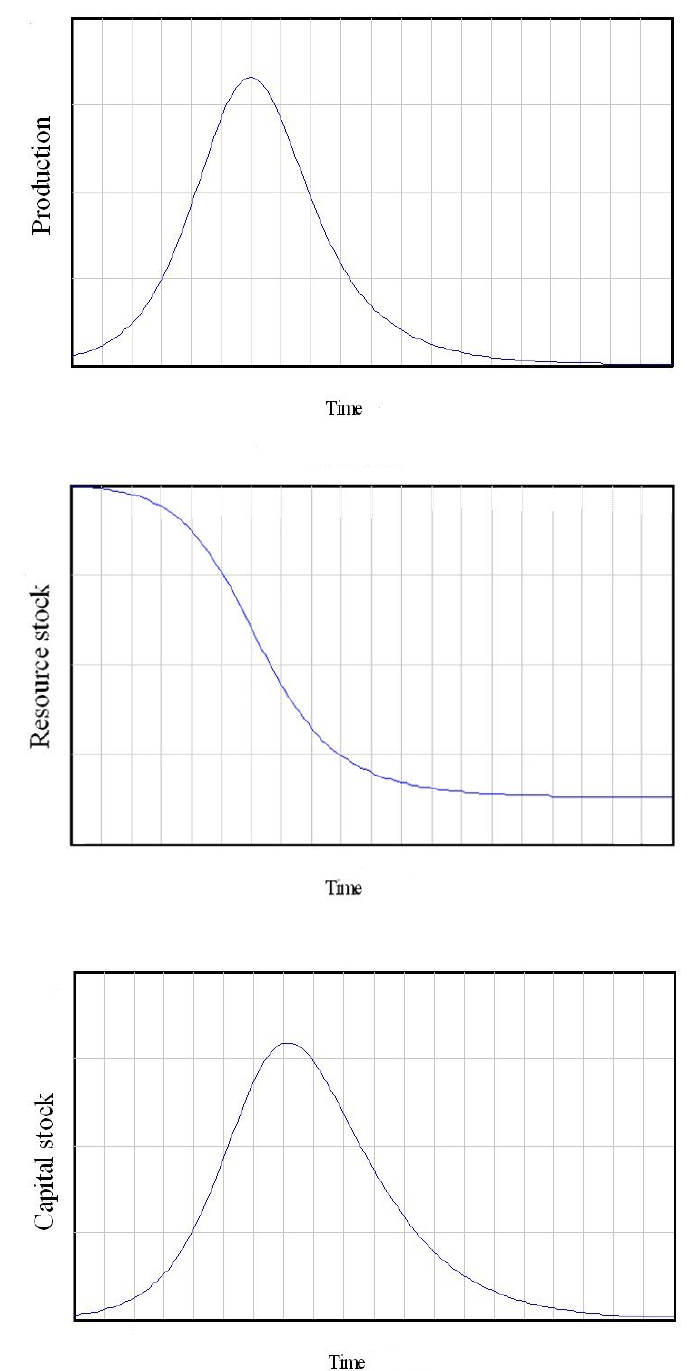
Figure 1. Qualitative solutions of the model described in the present paper. The three parameters shown are 1) the production rate (upper curve), 2) the amount of resource available (middle curve) and 3) the accumulated capital (lower